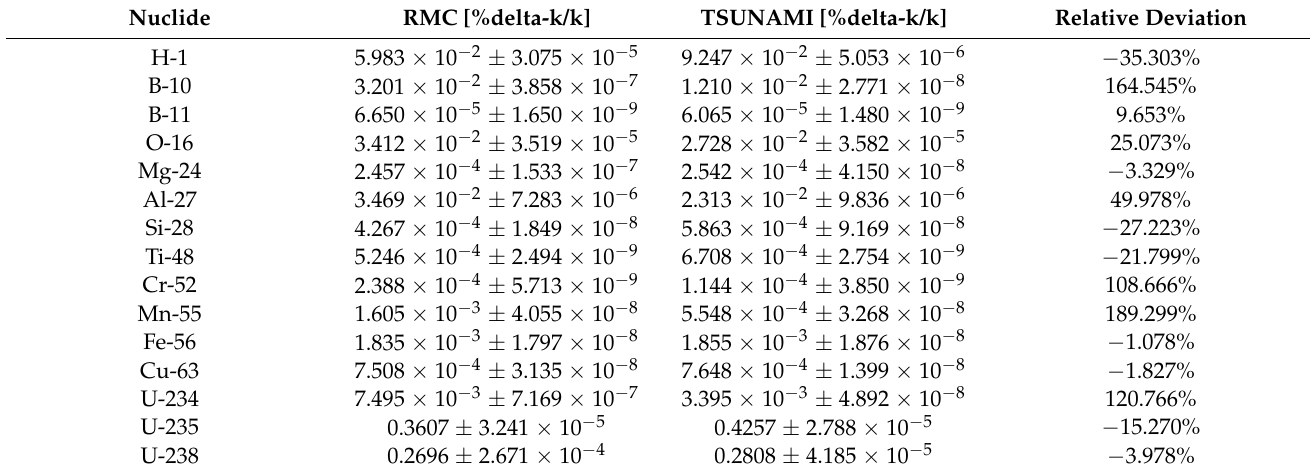
Table 7. Uncertainty of nuclides (SCALE 56-group-cov7.1 covariance library).